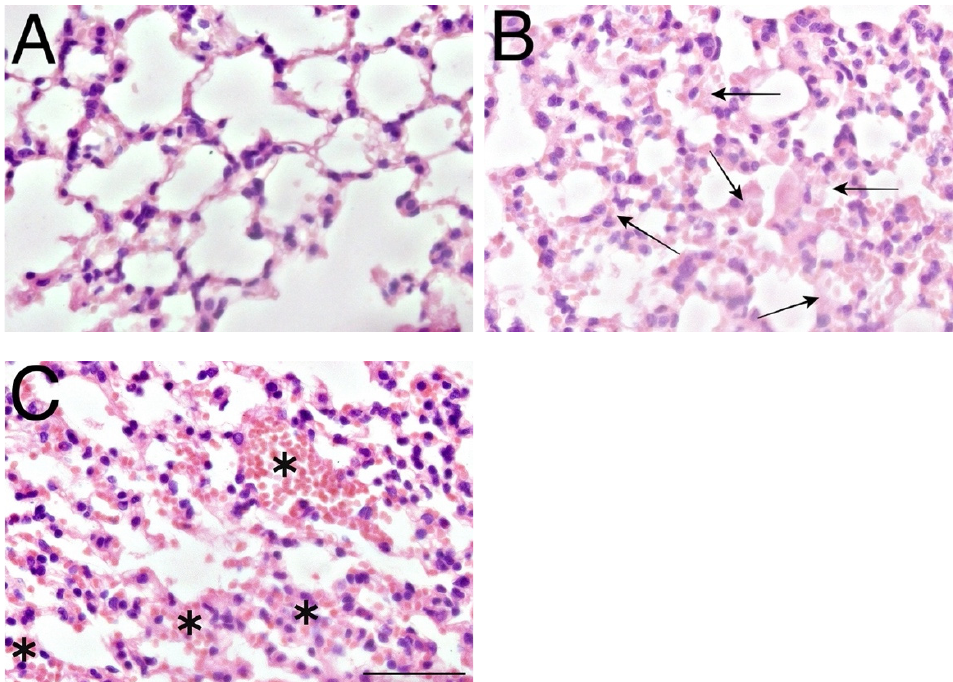
Figure 5. Histopathological effects of GPs on the lung tissue of C57Bl/6 mice after 21 days. Representative microphotograph of control mice group ( A ); ( B , C ) mice exposed to 50 μ g/mL GPs. Arrows indicate a thickened alveolar wall; asterisks indicate red blood cells in the lung interstitial tissue. The scale bar = 50 μ m, staining haematoxylin-eosin.